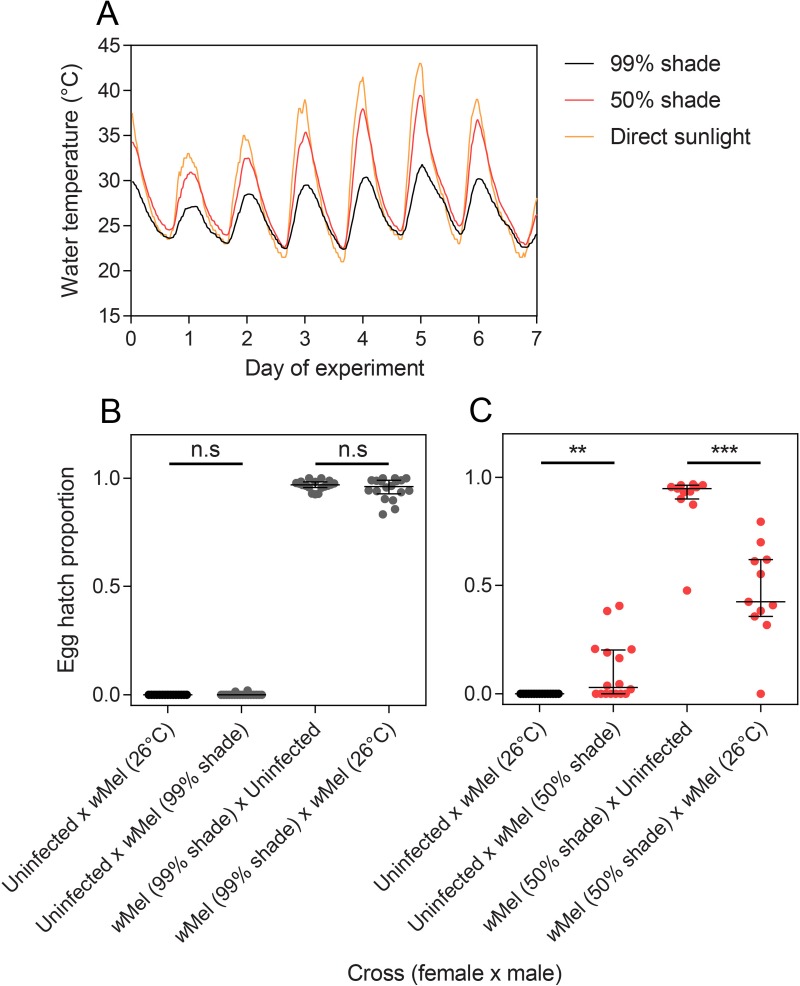
Temperature cycles and the resulting egg hatch proportions from crosses in the first field experiment.(A) Temperature cycles experienced in buckets (8 L) from the 10th to the 17th of January 2018. (B-C) Egg hatch proportions of crosses with wMel-infected adults when larvae were reared under 99% shade (B) or 50% shade (C) in buckets. All error bars are medians with interquartile ranges. ** P < 0.01, *** P < 0.001 by Mann-Whitney U test.